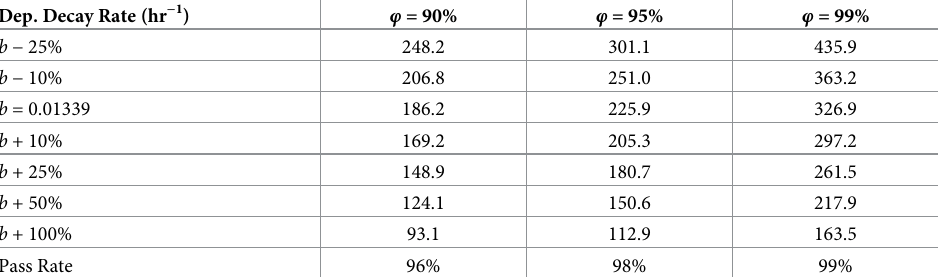
Table 3. Minimum depuration times ( T WCV ) for varying decay rates and NoV assurance levels. Simulated NoV test results of 10-oyster homogenates, which had undergone depuration using each parameter set { b , φ , T WCV } are shown. Times are in